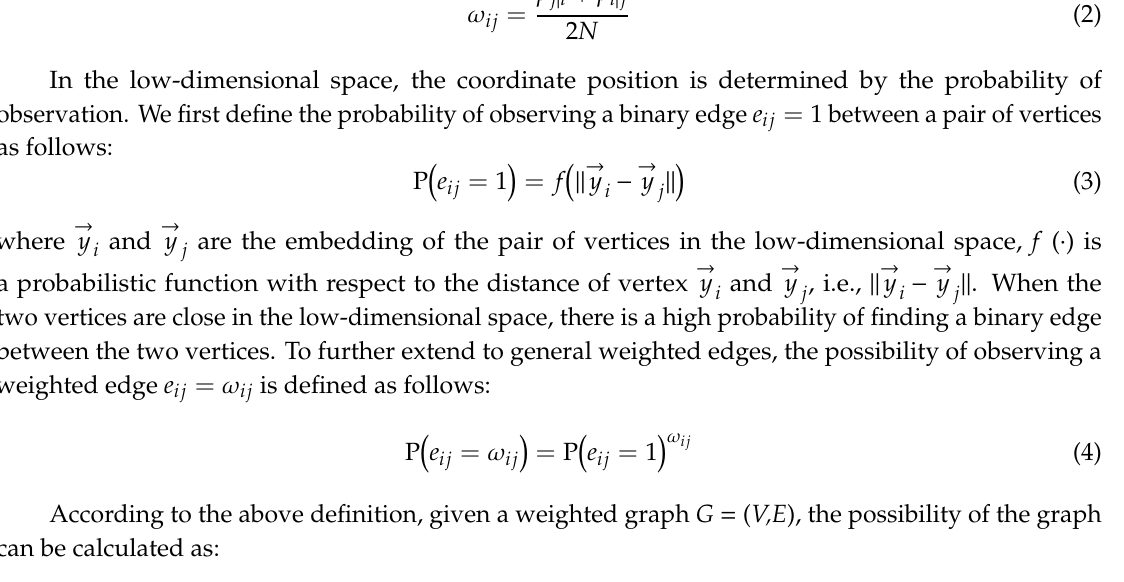
algorithm. The main improvement points include an e ffi cient kNN graph construction algorithm, a low-dimensional space visualization algorithm and an objective